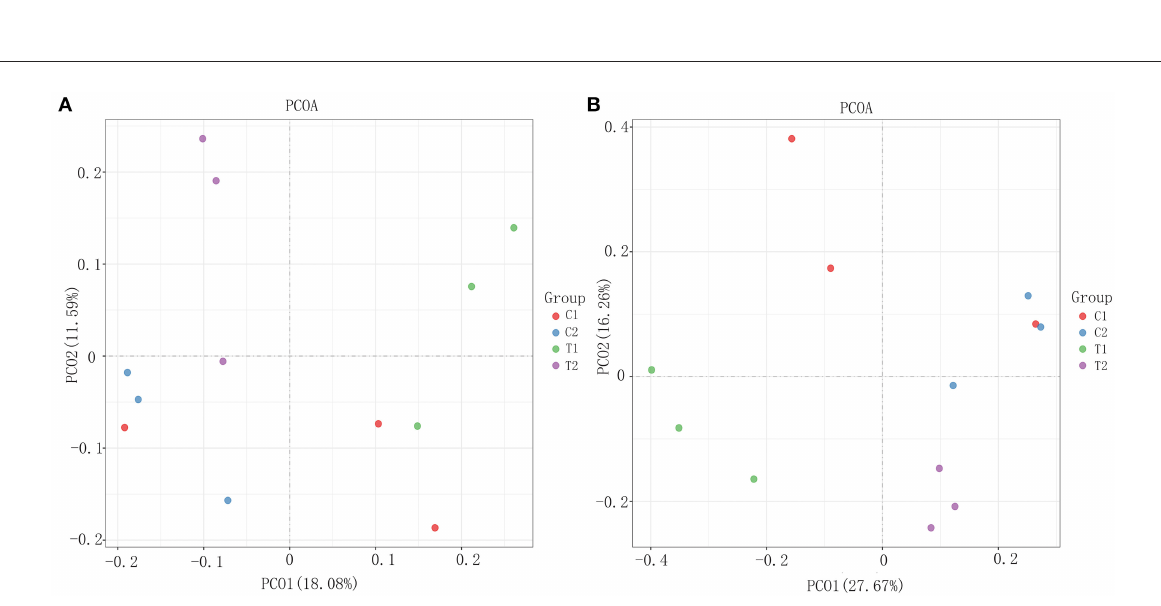
FIGURE4 The β diversity analysis results. (A) Weighted Unifrac PCoA scatter plot; (B) Jaccard PCoA scatter